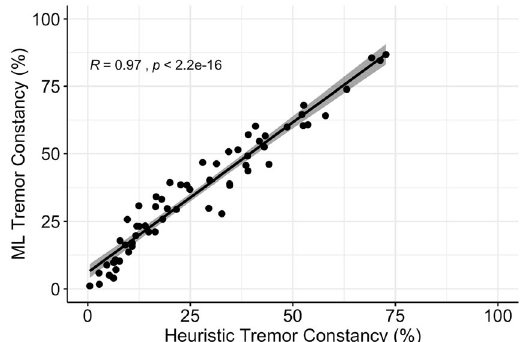
Fig. 2 Agreement between the heuristic algorithm and ML classi fi er for resting tremor detection. Resting tremor constancy was estimated as a fraction of the total visit duration when resting tremor was detected from sensor data. Each point corresponds to one subject visit, solid line represents line of best fi t and shaded region represents the con fi dence